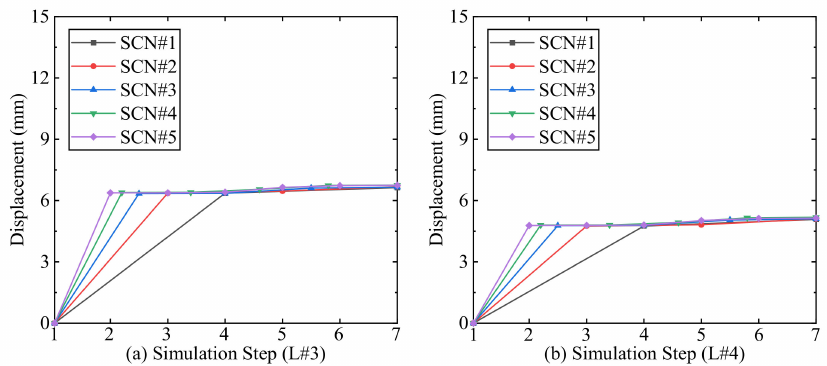
Figure 4. Displacement of sidewall middle of level #3 and level #4.